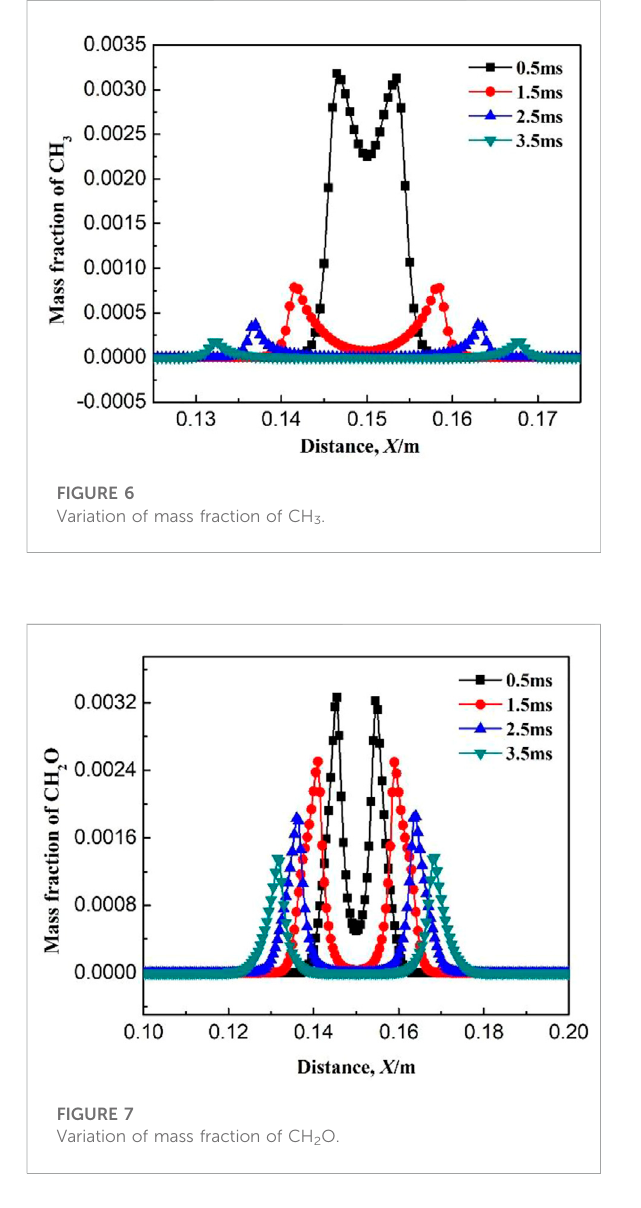
FIGURE 7 Variation of mass fraction of CH 2 O.